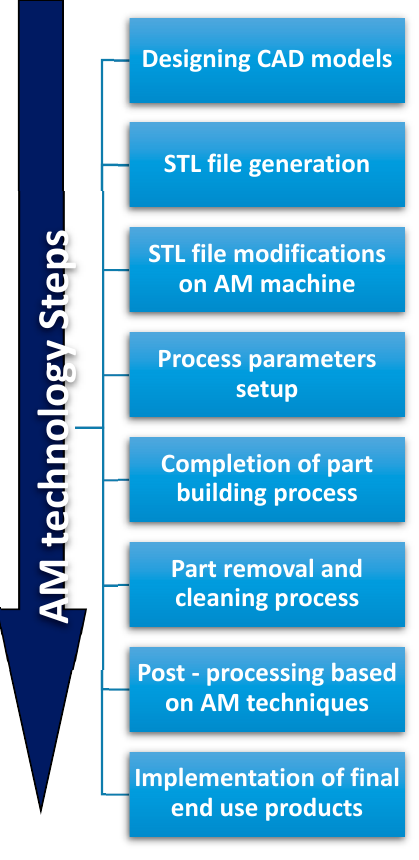
Figure 1. Additive Manufacturing processing steps.